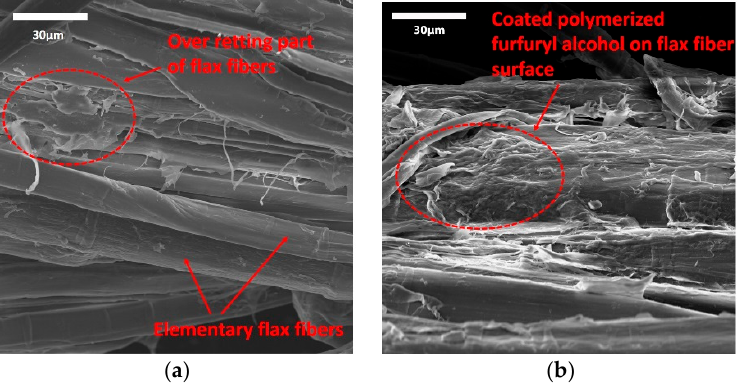
Figure 2. ( a ) Morphology of untreated flax fiber surfaces; and ( b ) morphology of FA treated flax fiber surfaces.